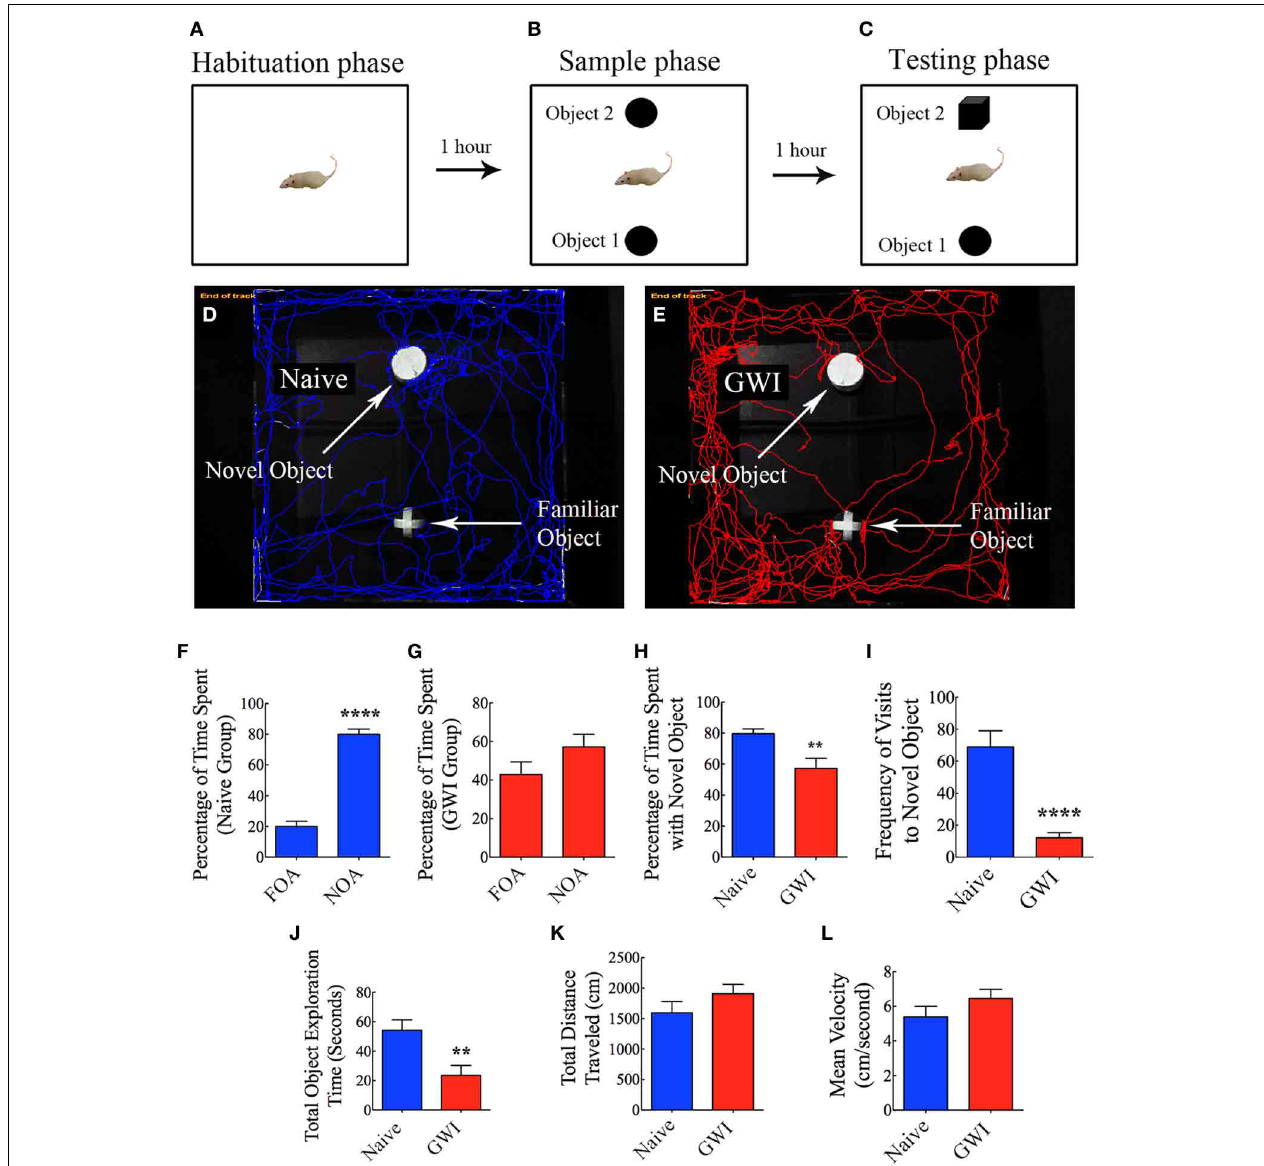
FIGURE 4 | Exposure to Gulf War illness related (GWIR) chemicals and stress causes object recognition memory deficits as revealed by a novel object recognition test. (A–C) Show a schematic representation of three trials and inter-trial intervals in this test. (D,E) Show representative track plots of a naive rat (D) and a rat with GWI (E) recorded by Noldus Ethovision XT tracking system in the testing phase. Arrows denote locations of novel and familiar objects in the testing phase. Note that the naive rat spent more time exploring the novel object (D) whereas the rat with GWI did not show